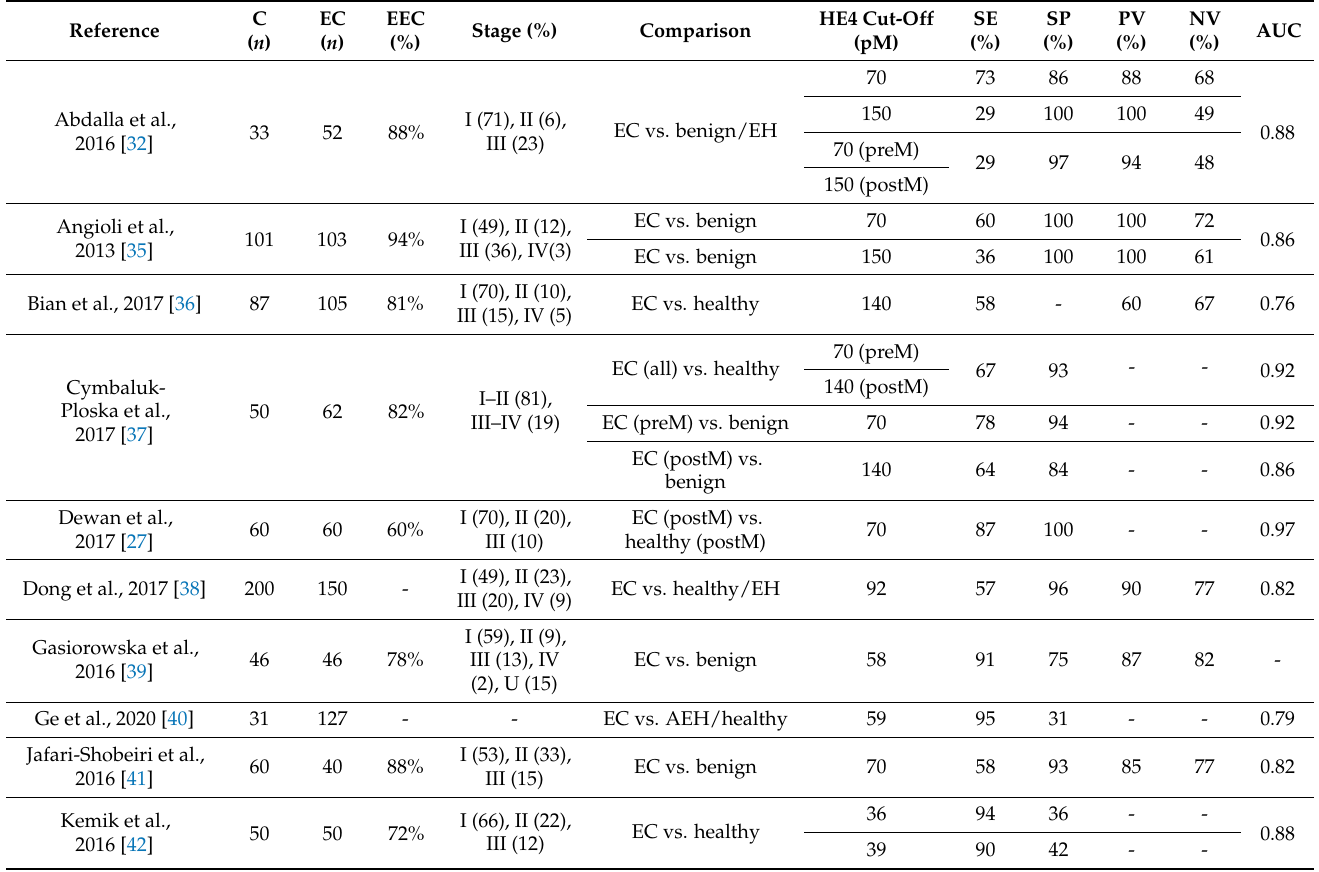
Table 1. Serum HE4 cut-off values and performance for EC